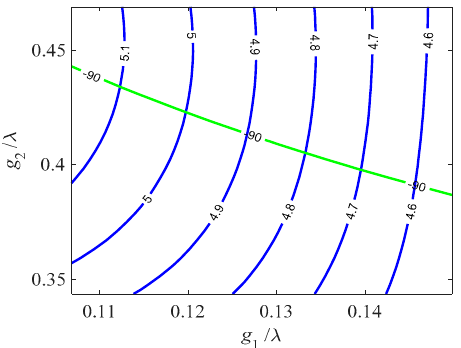
Figure 5. Reflectivity and unidirectional angle dependence on the two gaps between three fingers.